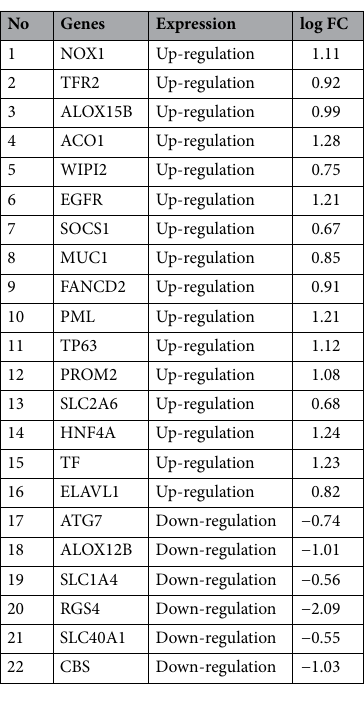
Table 1. Ferroptosis-related DEGs in